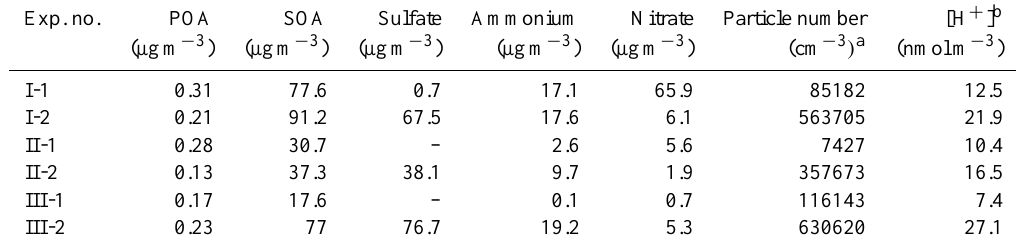
Table 3. Summary of the final results during the photooxidation of LDGV exhaust. Exp. no. POA SOA